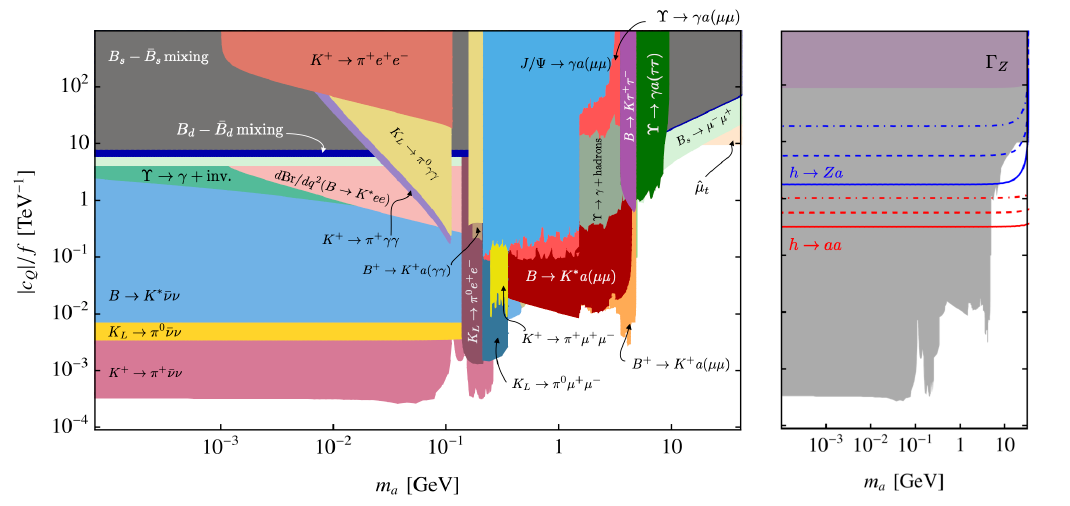
Figure 25 . Left: flavor bounds on universal ALP couplings to quark doublets with c Q = c Q 1 , and all other Wilson coefficients set to zero at the scale Λ = 4 πf and f = 1 TeV. Right: constraints from flavor observables (light gray) are compared to the constraint from Z → aγ decays from the LEP measurement of the Z boson width. Contours of constant Br ( h → aa ) = 10 − 1 , 10 − 2 and 10 − 3 are depicted as red dotted, dashed and solid lines, respectively. Contours of constant Br ( h → Za ) = 10 − 1 , 10 − 2 and 10 − 3 are shown as blue dotted, dashed and solid lines,